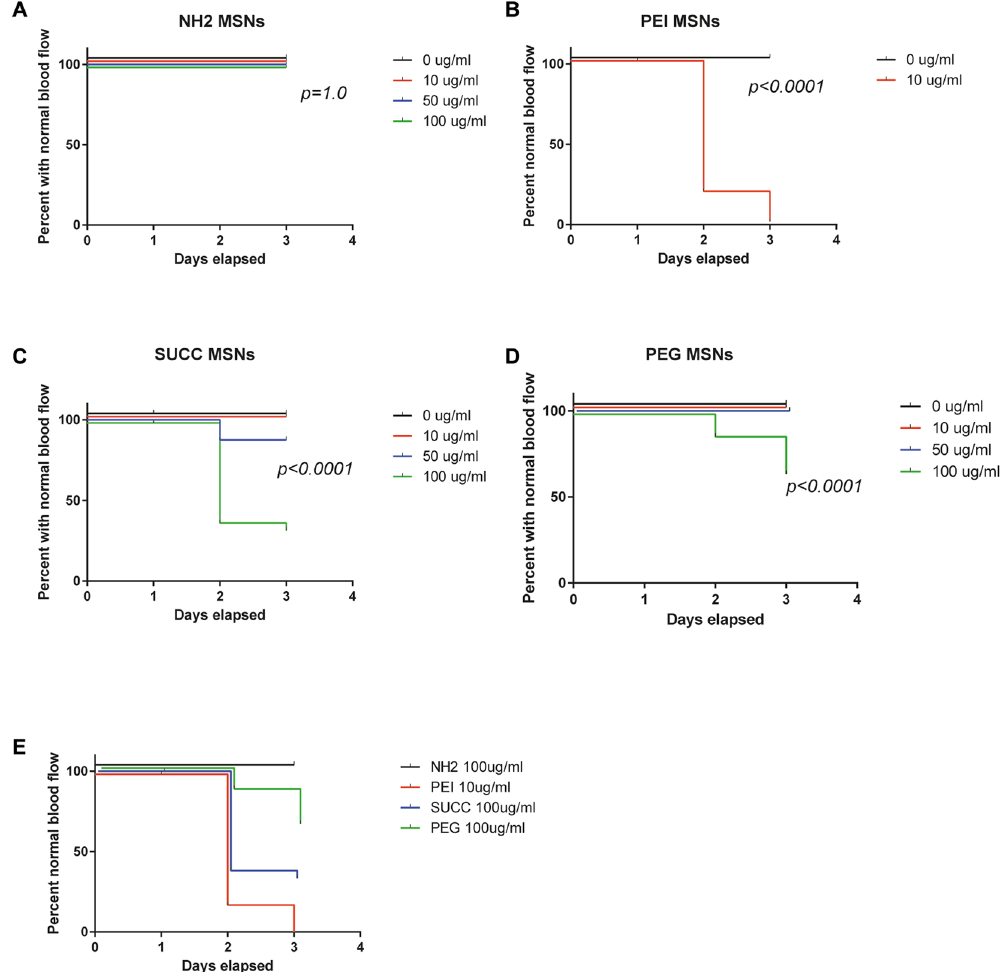
Figure 4. Surface functionalization affects cardiovascular toxicity of MSNs. The graphs show percentage of dechorionated embryos that show normal blood circulation upon treatment with NH2. PEI, SUCC and PEG MSNs at denoted concentrations. The treatment was initated at 24hpf and cardiovascular function analysed at 72 and 96 hpf. N = 24 embryos/treatment, except in PEI-MSN 0 μ g/ml (n = 25), SUCC-MSN 0 μ g/ml (n = 23), SUCC-MSN 10 μ g/ml (n = 23) and SUCC-MSN 100 μ g/ml (n = 25). Higher concentrations (50 and 100 μ g/ml) of PEI-MSNs were not assessed due to high lethality. Each embryo was followed throughout the experiment and cardiovascular function was visually scored normal or abnormal day 3 and 4. G) Comparison of survival between MSNs at highest used